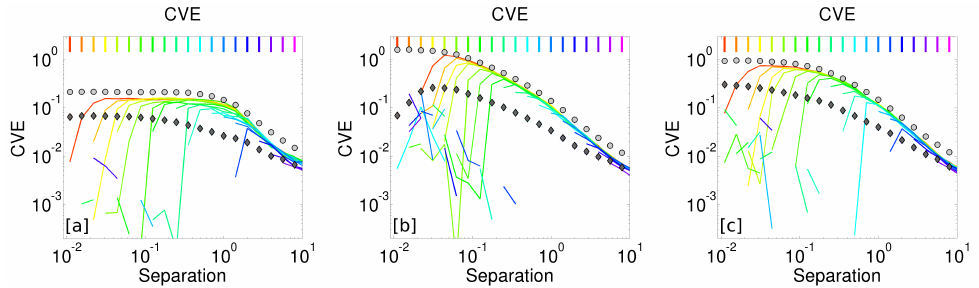
Figure 6. ( a ) CVE (˜ λ ) computed using different initial conditions (Dirac δ distributions centred on the reference separation thresholds) for model run A. The initial separation is color coded. The dots and diamonds represent the FSLE and CVE, respectively, computed using the reference (Heaviside distribution) initial separation. The colored ticks on the top x-axis correspond to the color-coding of the plain lines. ( b ) Same as ( a ) for run B. ( c ) Same as ( a ) for run C.